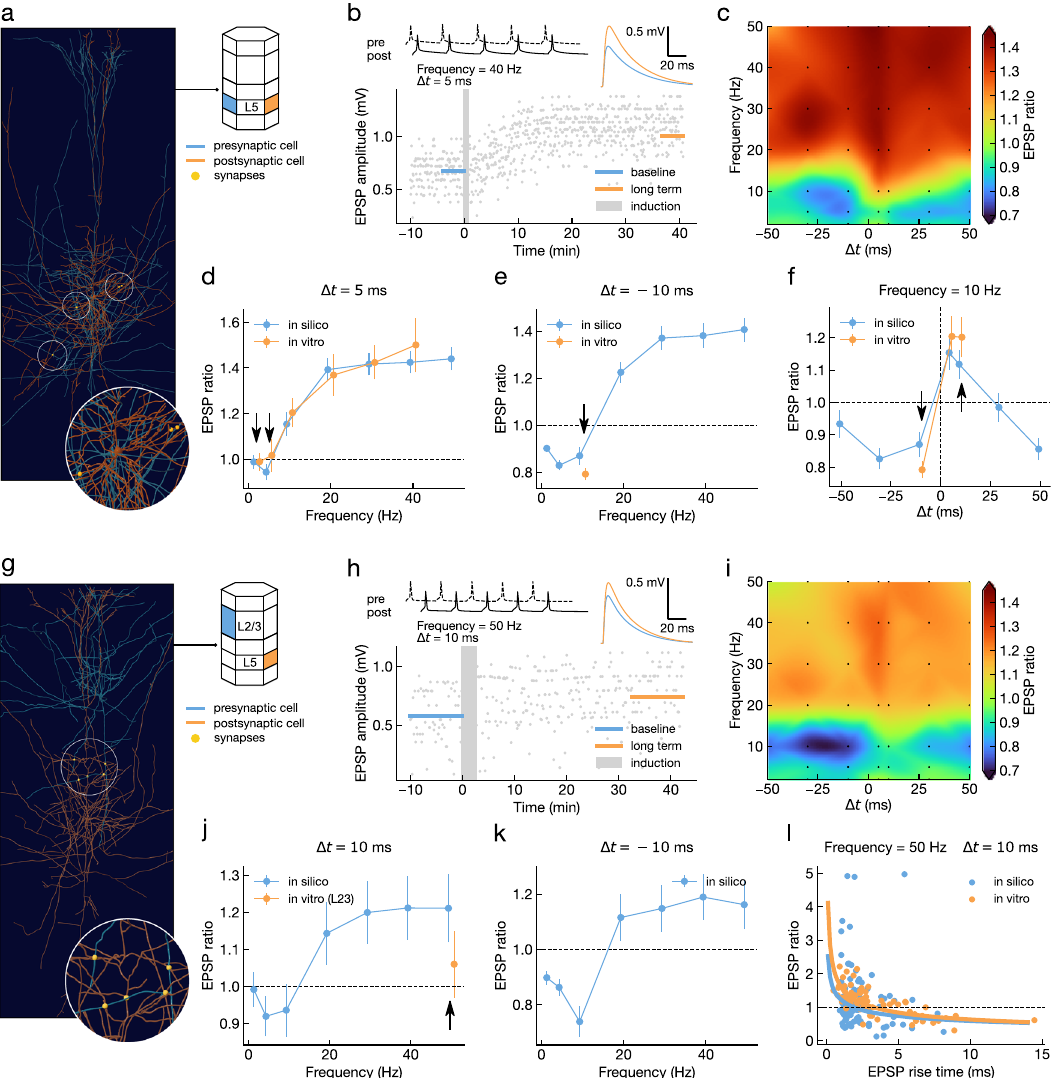
Fig. 3 Comparison of in vitro and in silico LTP/LTD outcomes for two distinct populations of synapses onto L5-TTPC. a 3-D rendering of a representative pair of connected L5-TTPCs in the in silico model. Inset shows a magni fi ed view of some of the synapses mediating the connection (yellow spheres). b Evolution over time of simulated EPSP amplitude (bottom) during a typical plasticity induction protocol (top left; one burst shown out of 10). Mean EPSP amplitudes (top right) are shown before (baseline; blue) and after (long term; orange) the induction protocol. c Timing and frequency dependence of LTP/LTD in silico for the protocol described in b ( n = 100). Simulated con fi gurations shown as black markers, with cubic interpolation elsewhere. d Comparison of in vitro and in silico frequency dependence of synaptic changes at Δ t = + 5 ms. Welch's unequal variances two-sided t-test was n.s. for every protocol ( p-value from low to high stimulation frequency: 0.988, 0.399, 0.550, 0.821, 0.940, 0.586; n = 100). e As in d for Δ t = − 10 ms. Welch's unequal variances two-sided t-test was n.s. ( p-value : 0.103; n = 100). f Comparison of in silico and in vitro STDP at a frequency of 10 Hz. Welch's unequal variances two-sided t-test was n.s. for every protocol ( p-value from negative to positive stimulation timing: 0.103, 0.550, 0.299; n = 100). Experimental data (in vitro) from Markram et al. 12 . Panels g – k as in a – e for L2/3-PC to L5-TTPC connections. For j , Welch's unequal variances two-sided t- test was n.s. ( p-value : 0.245; n = 100). l Dependence of LTP/LTD on dendritic location. EPSP rise time is used as a correlate of the average contact distance from soma for comparison with Sjöström and Häusser 36 (in vitro; includes also connections between L5-TTPCs and those acquired via extracellular presynaptic stimulation). Circles represent individual experiments, while solid lines are power-law fi ts to the data (in silico, blue, f ( x ) = 1.22 x − 0.32 ; in vitro, orange, f ( x ) = 1.61 x − 0.41 ). All panels report EPSP ratio data as mean ± SEM. Black arrows indicate stimulation protocols used to optimize model parameters. For the full distribution of in silico experiment outcomes see Supplementary Fig. A.10 (L5-TTPC to L5-TTPC) and Supplementary Fig. A.11 (L2/3-PC to L5- depressed and potentiated states. That is, the maximum observed in the visual cortex using a comparable experimental magnitude of LTP/LTD obtainable in our model is constrained protocol 14 , and were reproduced by our model (Supplementary Fig. A.4a). The observed quantitative match between in vitro and by the initial state of all synapses (i.e potentiated or depressed) in silico data at higher frequencies is compatible with our and by how much each synapse can change. For example, a pool assumptions on the initial ratio of potentiated over depressed of connections having all synapses initialized in the potentiated synapses, and the conductance and release probabilities of the state will not produce LTP for any stimulation protocol, as there